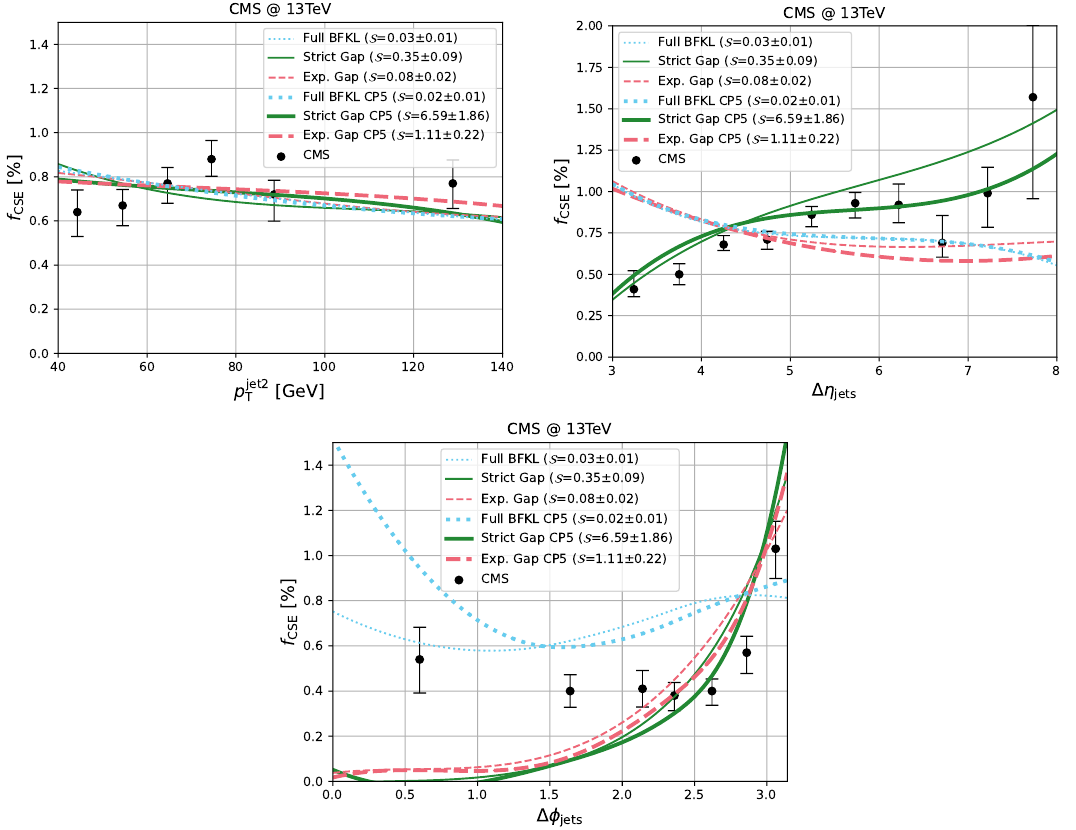
(top left), ∆ η (top right) and ∆ φ (bot- jets jets T